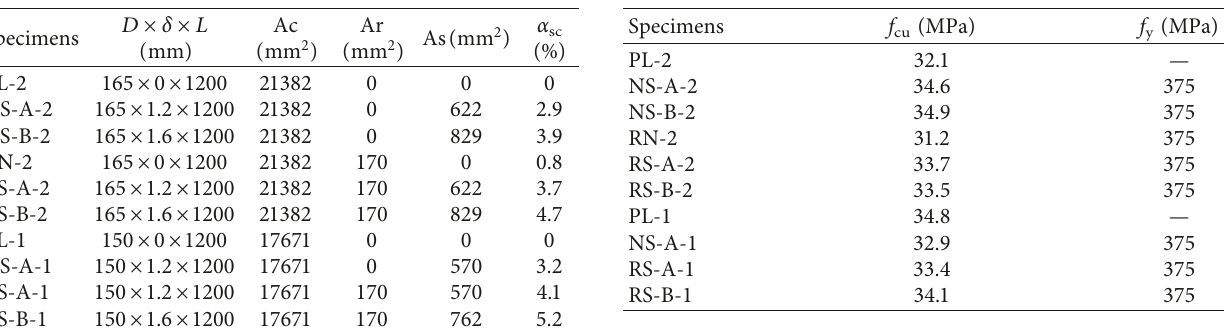
Table 1: List of columns for CFST columns without foundation.